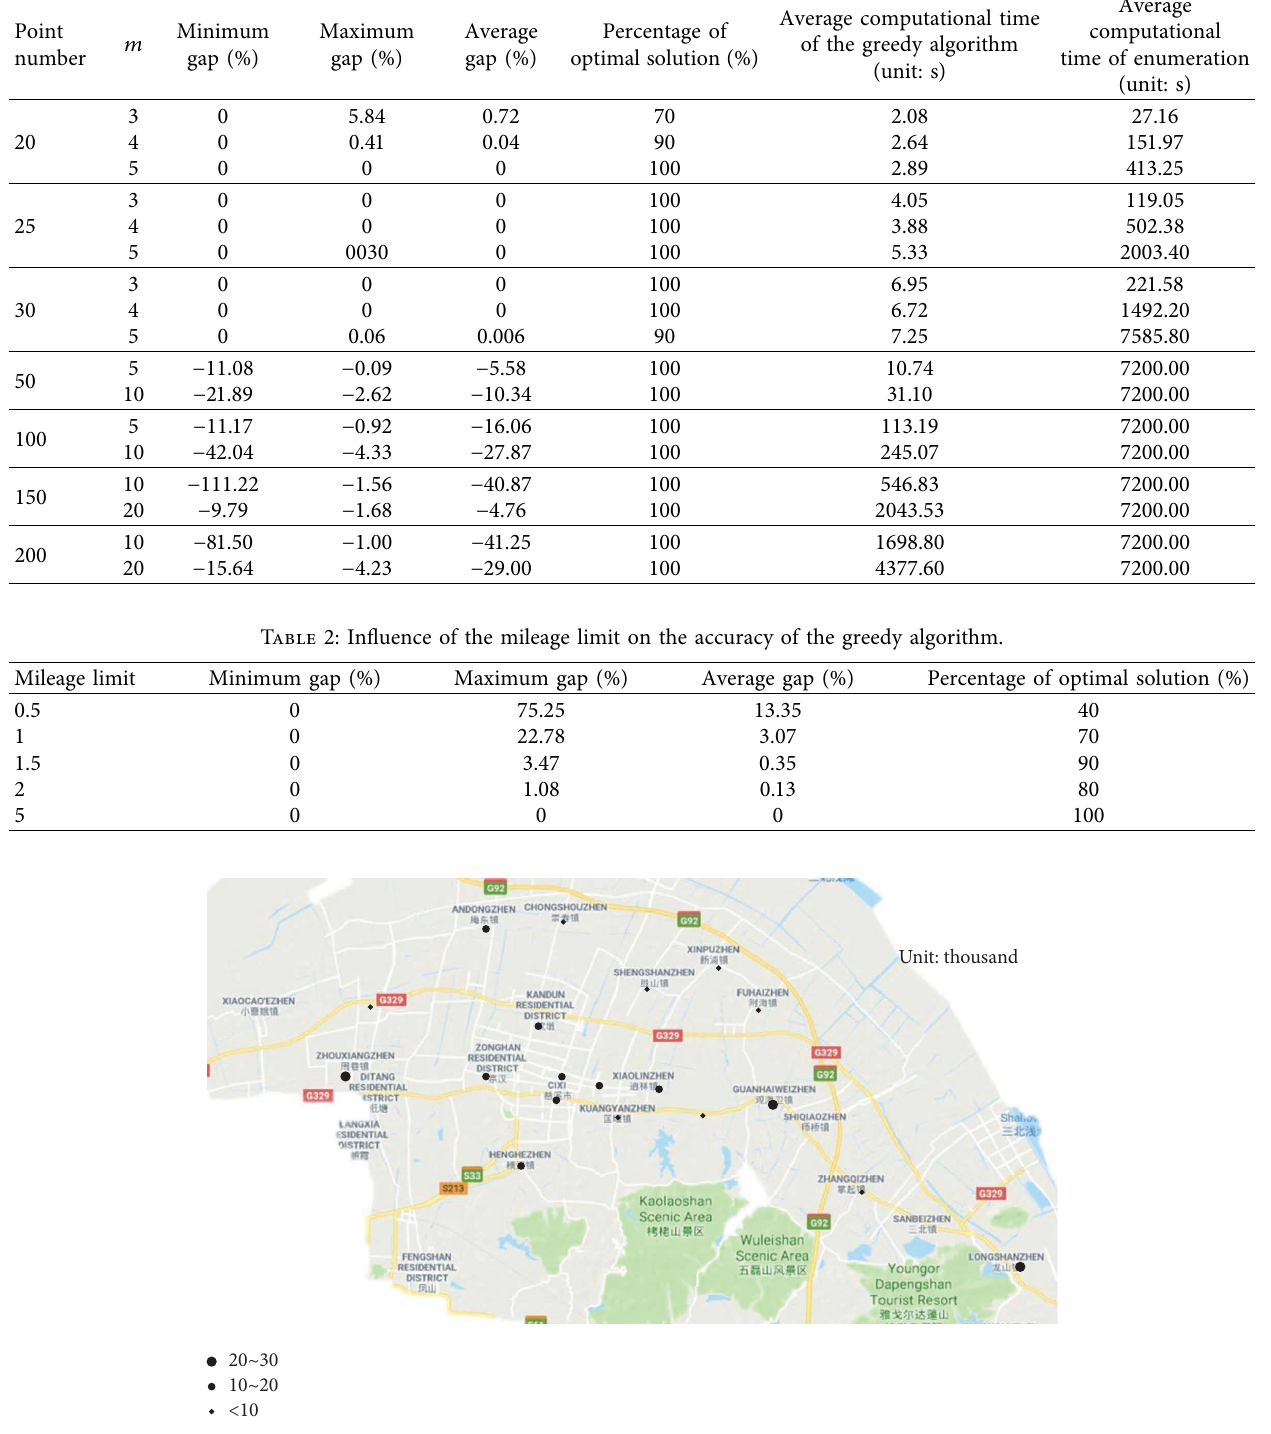
Figure 2: Te map of